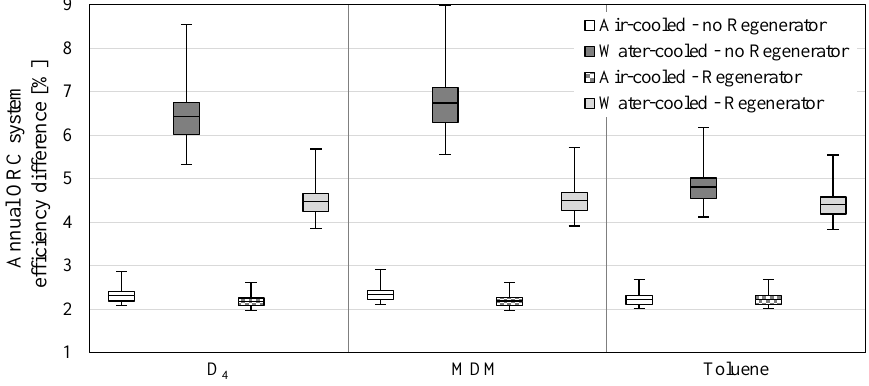
Figure 11. Annual ORC system efficiency relative difference when compared to ORC nominal efficiency.